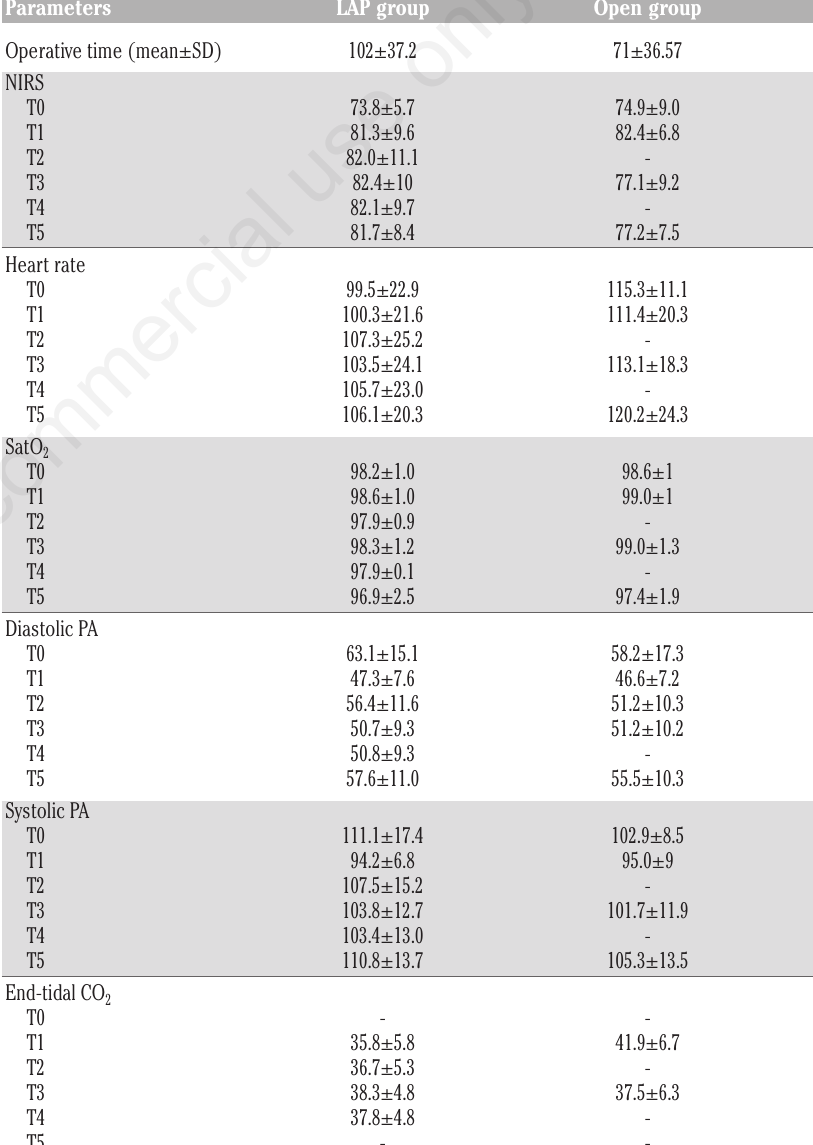
Table 1. Hemodynamic mean values at the different surgical time